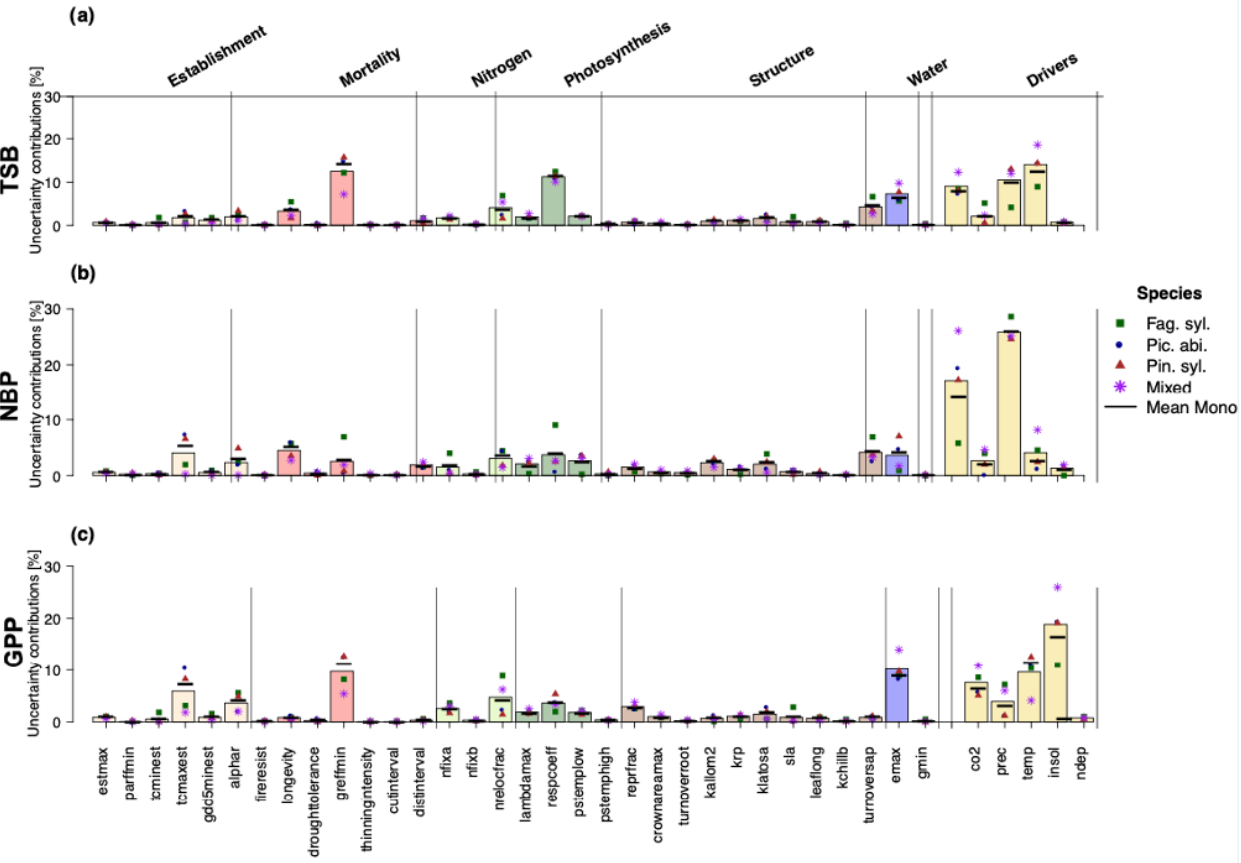
Figure 2. Uncertainty contributions in percent of the individual parameters and environmental drivers regarding (a) total standing biomass, (b) net biome productivity, and (c) gross primary production showed no strong differences between Fag. syl. (green squares), Pic. abi. (blue circles), and Pin. syl. (red triangles) and were stronger for monospecific stands than mixed stands (purple asterisks). The height of the bars reflects the mean over monospecific and mixed stands. Positive values for points and bars indicate a positive and negative values a negative relationship with the corresponding